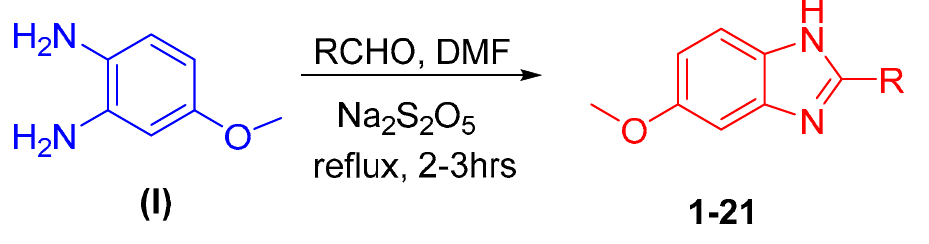
Figure 1. Rationale of the current work [27–30].